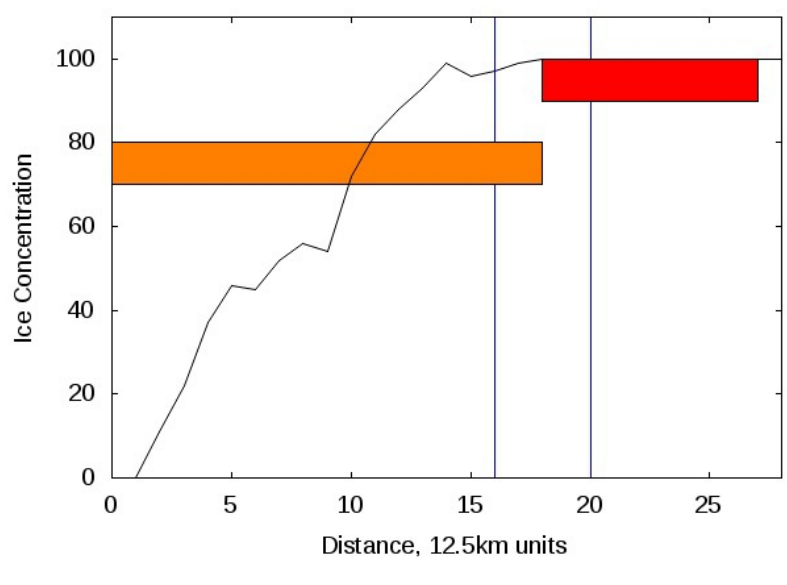
Figure 4. Ice concentration estimates from AMSR-E and National Ice Center charts over the path of the specular reflection point for June 23, 2005 data. The two vertical lines are the approximate start and end points for the GPS reflection (reflection traveling from right to left, covering approximately 53 km). The AMSR-E data is shown as the black trace, starting at 0 on the far left (open sea) and progressing upwards to 100 ice concentration towards the right. The National Ice Center concentrations of 70 to 80 percent and 90 to 100 percent are shown as orange and red shaded areas,